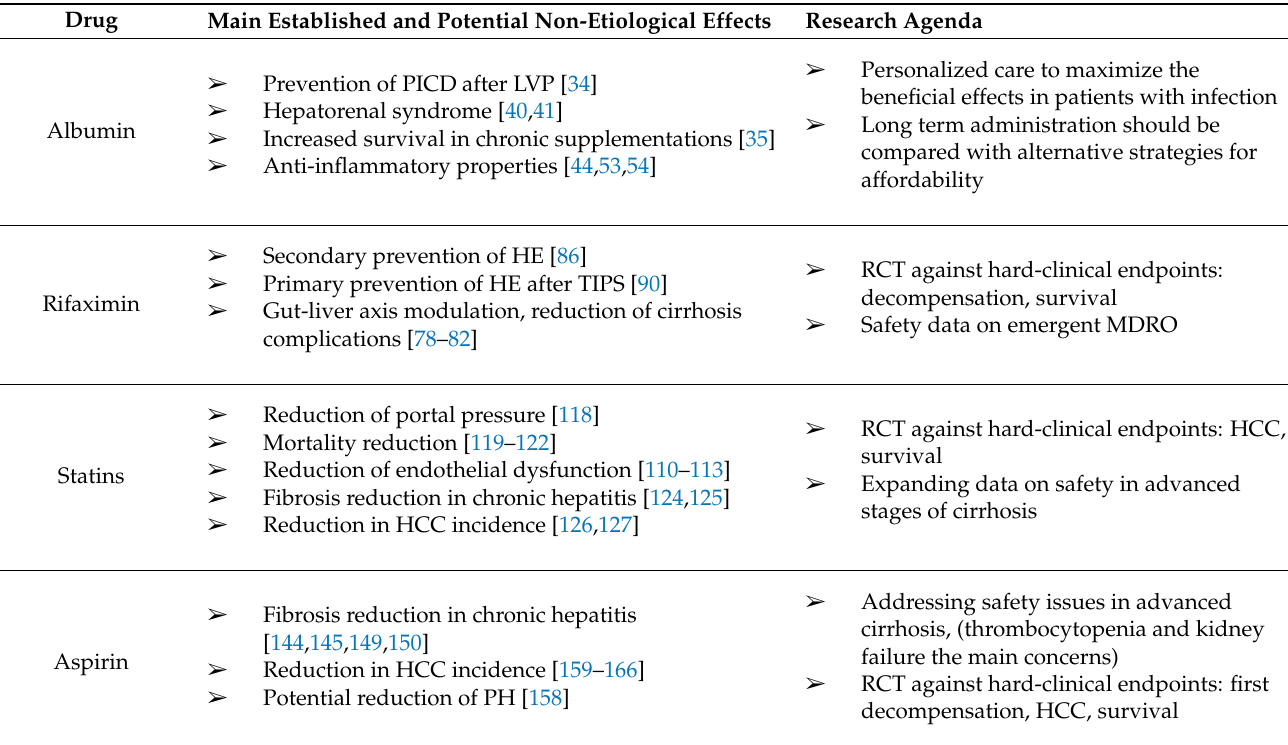
Table 1. Summary of established and potential non-etiological therapies in cirrhosis and portal hypertension and future research agenda in this